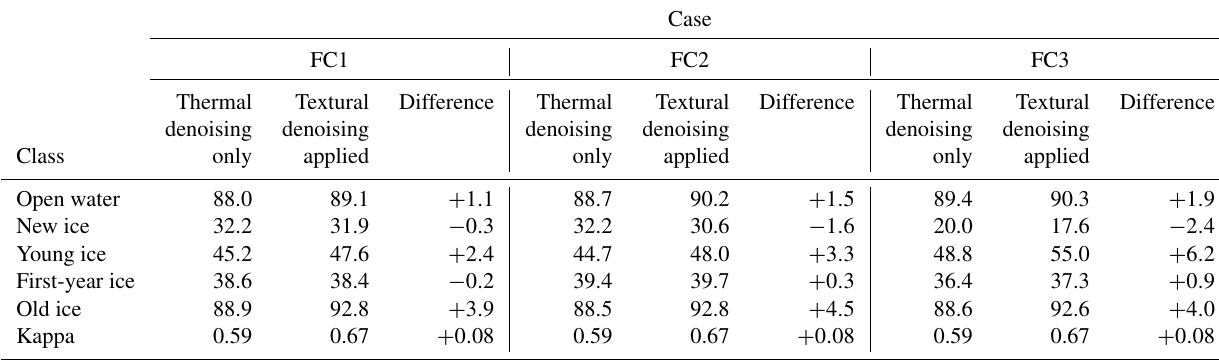
Table 5. Classification accuracies before and after applying textural denoising.